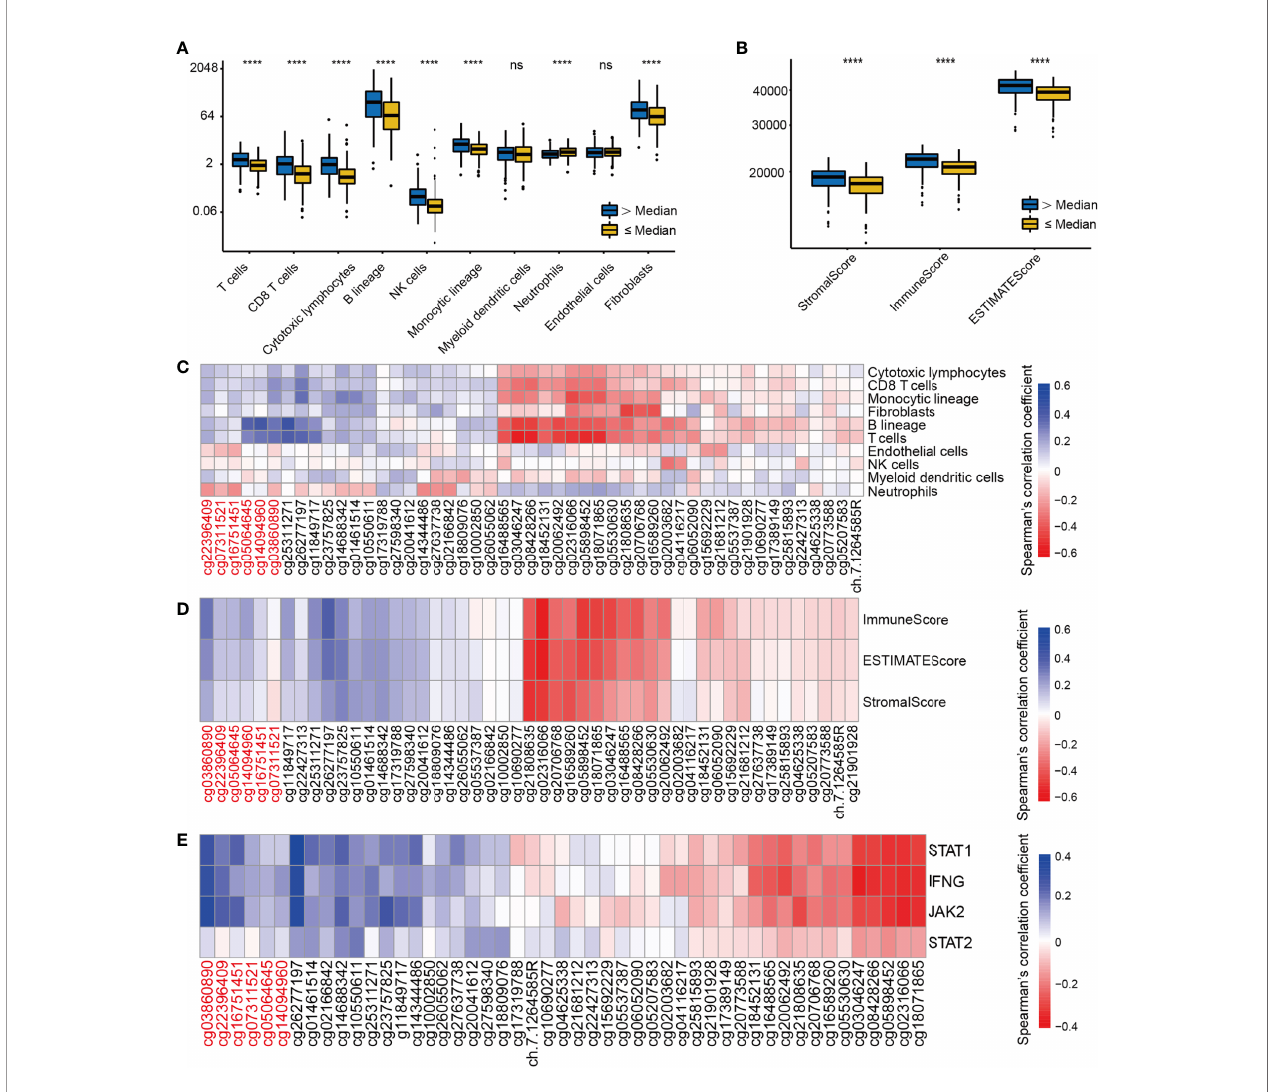
FIGURE 5 | The correlation of EGFR CpG sites methylation and immune cells in fi ltrates and IFN- g signature in LUAD. (A) The landscape of immune in fi ltration in LUAD according to the median EGFR methylation level by MCPcounter. (B) ESTIMATE scores in LUAD according to the median EGFR methylation level. (C – E) Correlation analysis between DNA methylation levels of 49 EGFR CpG sites and immune in fi ltration, ESTIMATE scores, IFN- g signature in the TCGA LUAD cohort. CpG sites labeled in red are located in the EGFR promoter region and in black in the gene body region. ****P < 0.0001, ns, not signi fi